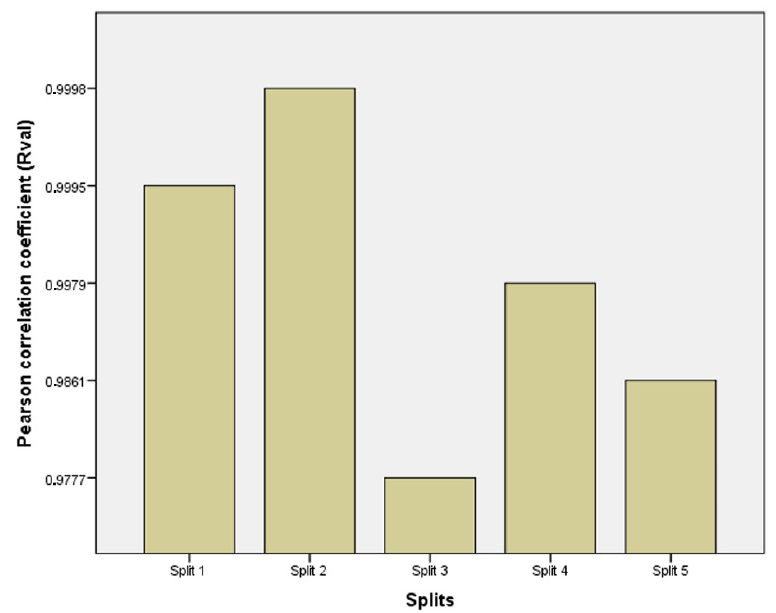
Figure 3. Performance measures of the DNN model using the K -fold cross-validation, with K = 5. Table 7. Comparison between the proposed DNN model and some of the empirical models found in the